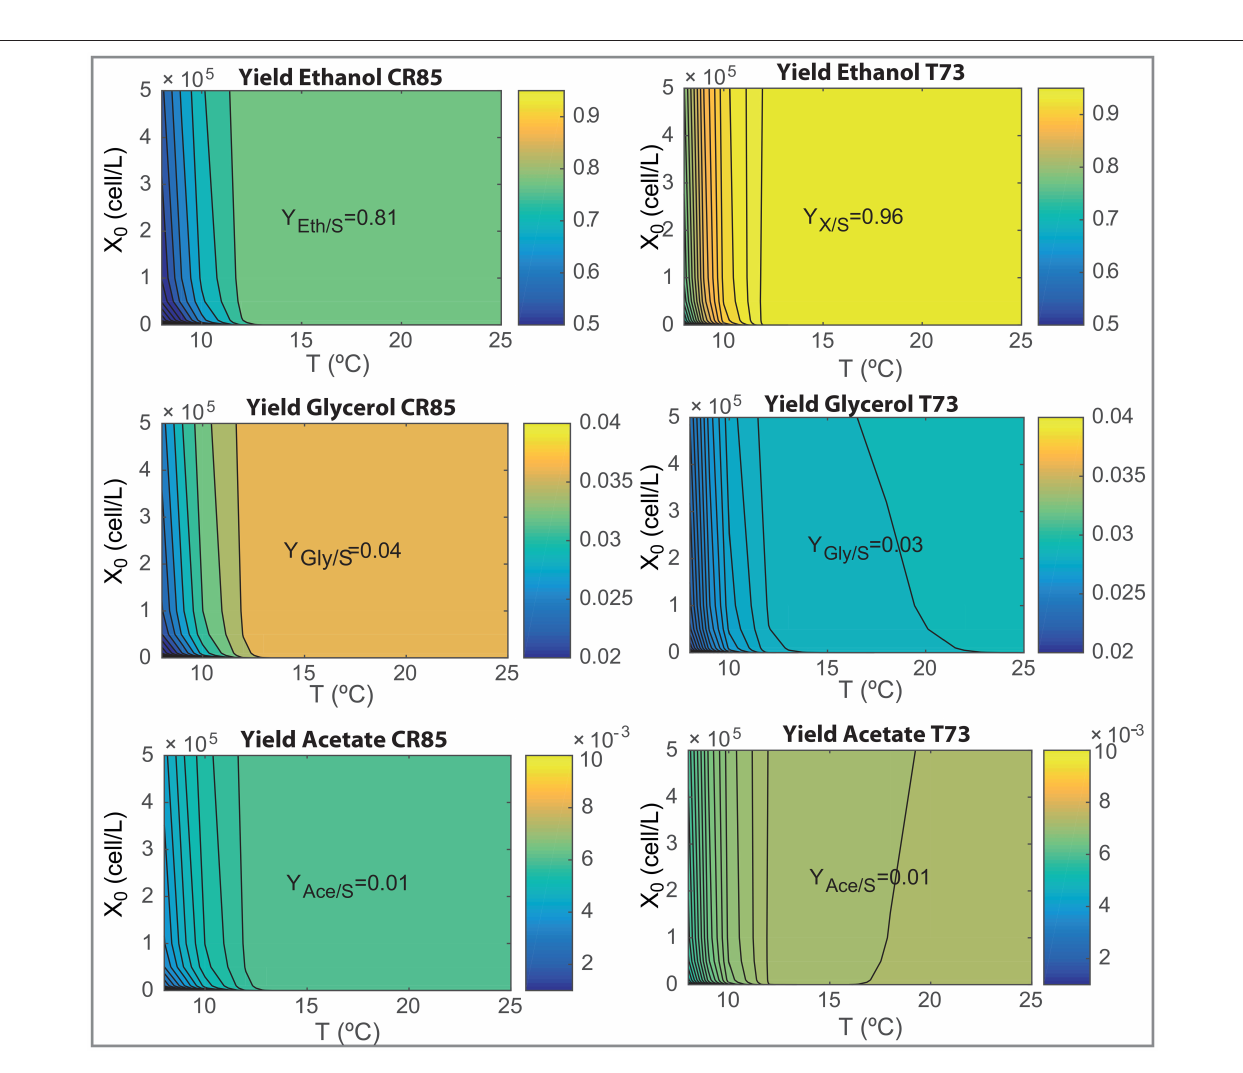
Frontiers in Microbiology | www.frontiersin.org